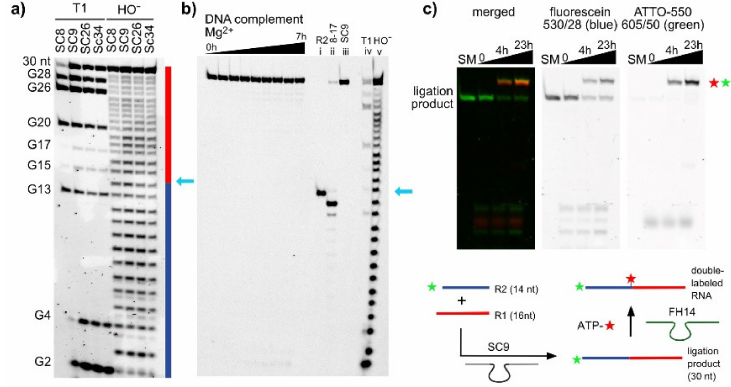
Figure 2. ( a ) The isolated 30-nt ligation products generated by SC8, SC9, SC26, and SC34 were analyzed by alkaline hydrolysis and RNase T1 digestion. The results confirm the continuous backbone of the linear RNA; the light blue arrow indicates the ligation site. ( b ) The ligation product of SC9 was hybridized to the complementary DNA (D5) and incubated with 100 mM MgCl 2 at pH 9.0 for up to 7 h. No cleavage was observed. In addition, site-specific cleavage by the 8-17 deoxyribozyme (lane ii, 20 mM Mg 2 + , 20 mM Mn 2 + , 40 mM Tris-HCl, pH 7.5, 5 h) confirms the 3 (cid:48) -5 (cid:48) -linkage at the ligation